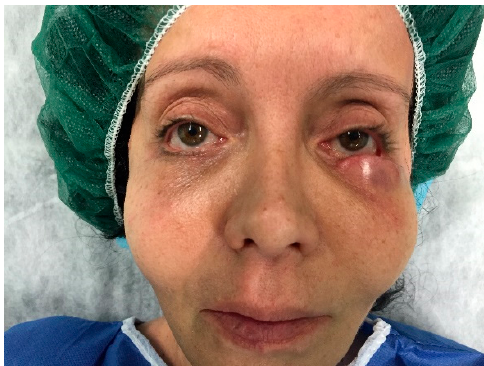
Figure 8. Upper displacement of the sub-malar implant.